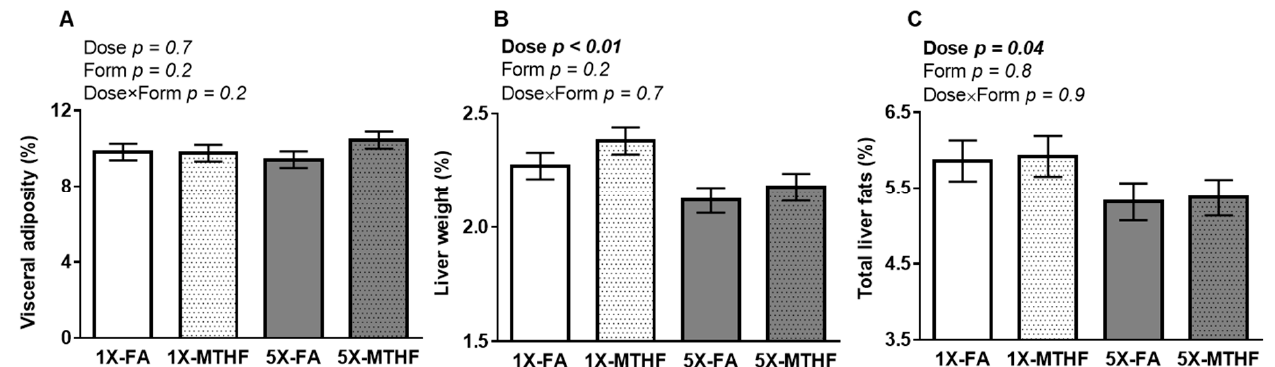
Figure 2. Percent ( A ) visceral adipose, ( B ) liver, and ( C ) total liver fat as adjusted per gram of final body weight in female offspring fed a high-fat diet for 19 weeks post-weaning. Values are least square Mean ± standard error of the mean (S.E.M.), n = 10-12/group. Analyzed by Two-way ANOVA with Dose (1X or 5X) and Form (FA vs. MTHF) as main factors and a Dose × Form interaction term. Significant at p < 0.05. Values in bold indicate significant effects. Abbreviations: AIN-93G rodent diet with either 1X-FA, recommended folic acid (2mg/kg diet); 5X-FA (10mg/kg diet); 1X-MTHF, equimolar recom-